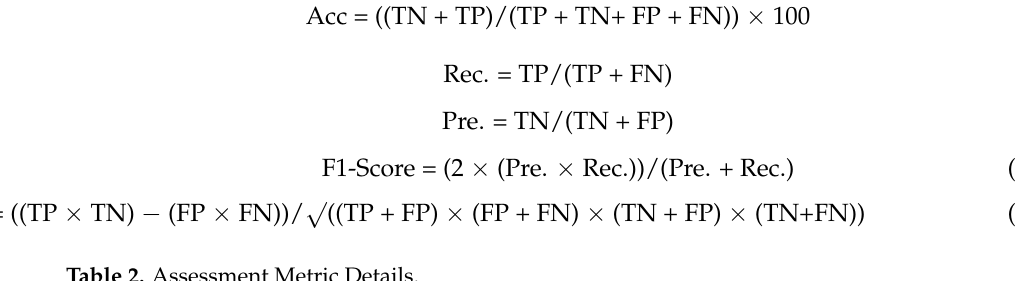
Table 2. Assessment Metric Details. Metric